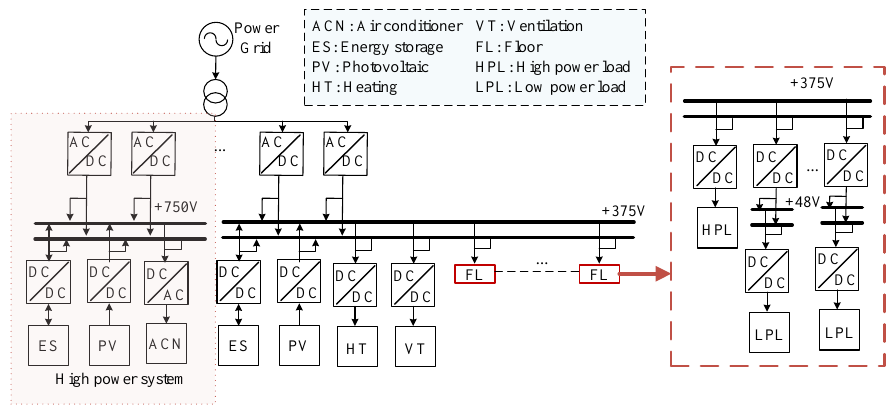
Figure 11. Separate power supply topology.